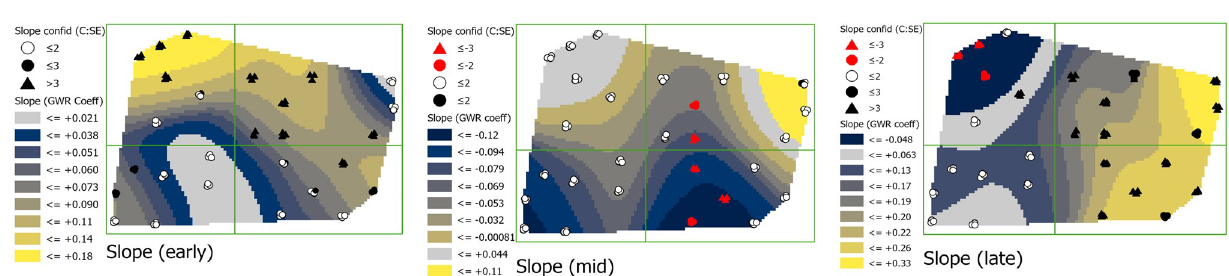
Fig 6. Maps showing early, mid-, and late season SLOPE coefficients with estimations of credence in coefficient values. Coefficient surface values were symbolized using a geometric interval classification scheme from blue to gold, with grey indicating the interval including zero (if present).